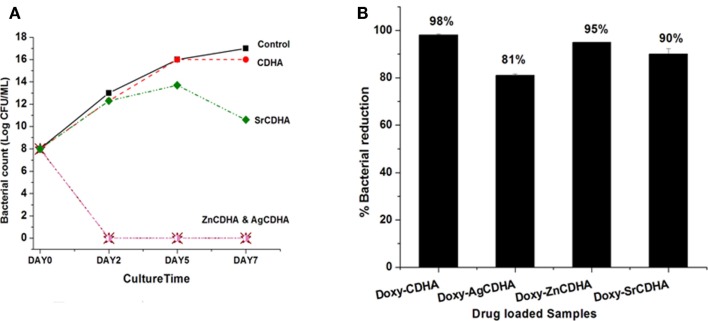
Time-kill curve showing log reduction against S. aureus for ion substituted CDHA samples (A) (n = 3; data shown as mean; p < 0.0001, one-way ANOVA). Antibacterial activity of CDHA and ion substituted CDHA nanoparticles loaded with doxycycline (doxy – doxycycline) against S. aureus
(B) (n = 3; data shown as mean ± SD; p < 0.005, one-way ANOVA).